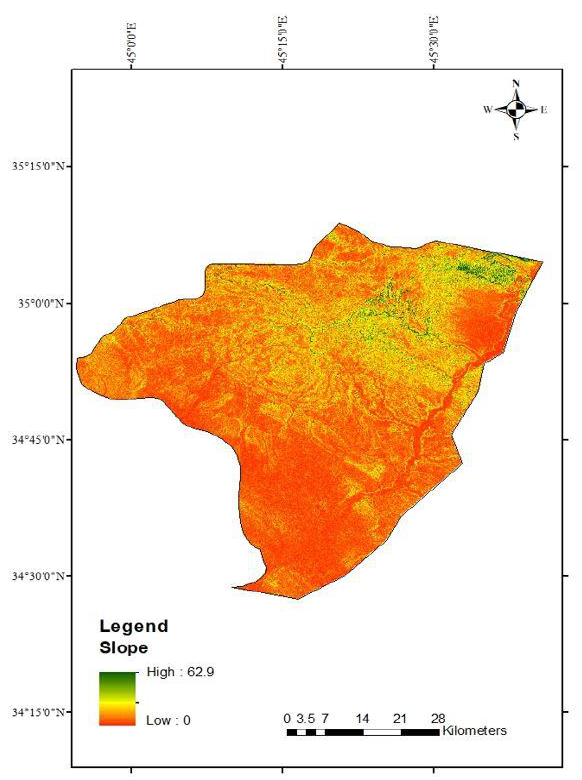
Figure 6. Slope map of the study area.